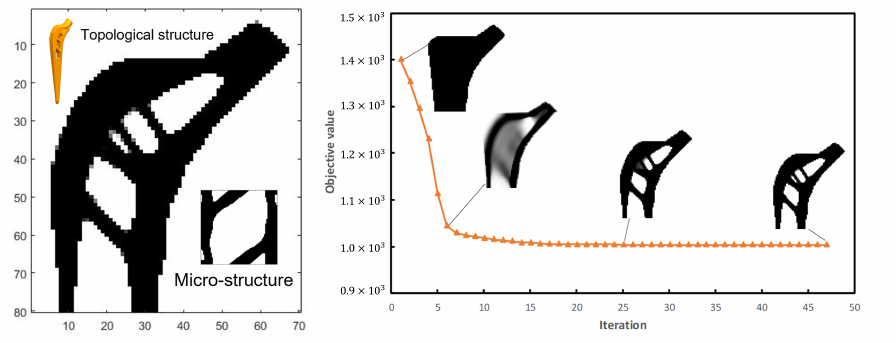
Figure 4. Topological configuration, micro-structure and solid model of B-type femoral